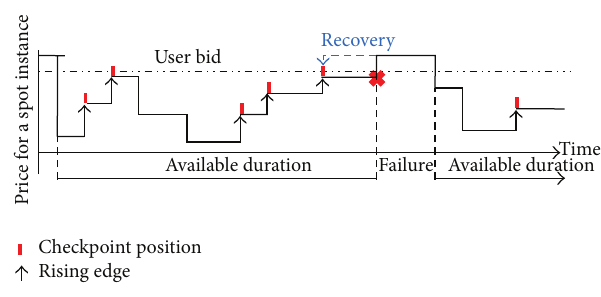
Figure 9: Rising edge-driven checkpointing.